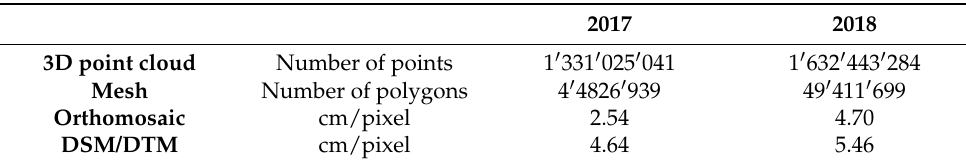
Figure 6. ( A , B ) 3D point cloud of a bridge crossing the Bevera Torrent acquired in 2017 ( A ) and 2018 ( B ); ( C , D ) 3D point cloud of a bridge crossing the Roia River acquired in 2017 ( A ) and 2018 ( B ). Figure 7 shows the distribution of the GCPs. The related mean error is less than 3 cm in almost the entire survey area, with only some spots with an error higher than 8 cm. Compatibly with the morphology of the area, the accessibility of private properties, and the satellite coverage, we tried to homogenously place the markers throughout the riverbanks. However, some areas were unreachable, such as the ones highlighted as 1 and